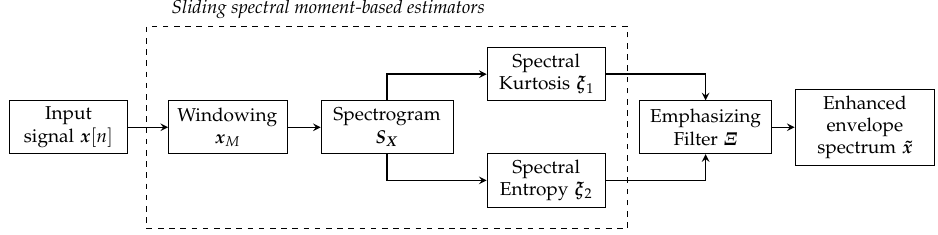
Figure 1. Validating pipeline of proposed short-time/-angle spectral analysis for vibration monitoring. Table 1. Testing dataset parameters: w τ , sliding short-time Fourier transform (STFT) window; M , length segment for computation of either sliding spectral entropy (SSE) or sliding spectral kurtosis (SSK) estimator. All parameters measured in